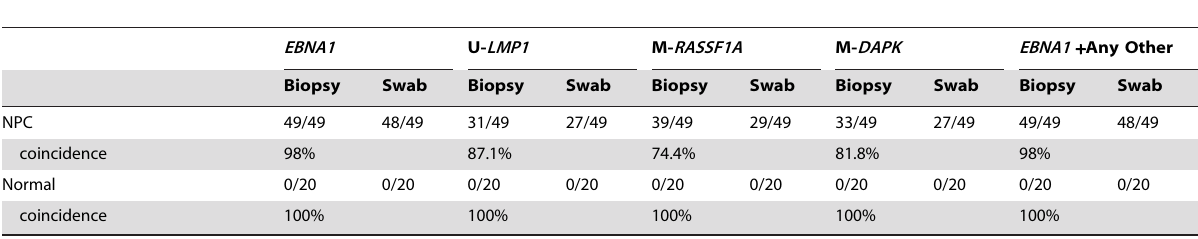
Table 2. Summary of MMSP pattern in NPC and noncancerous